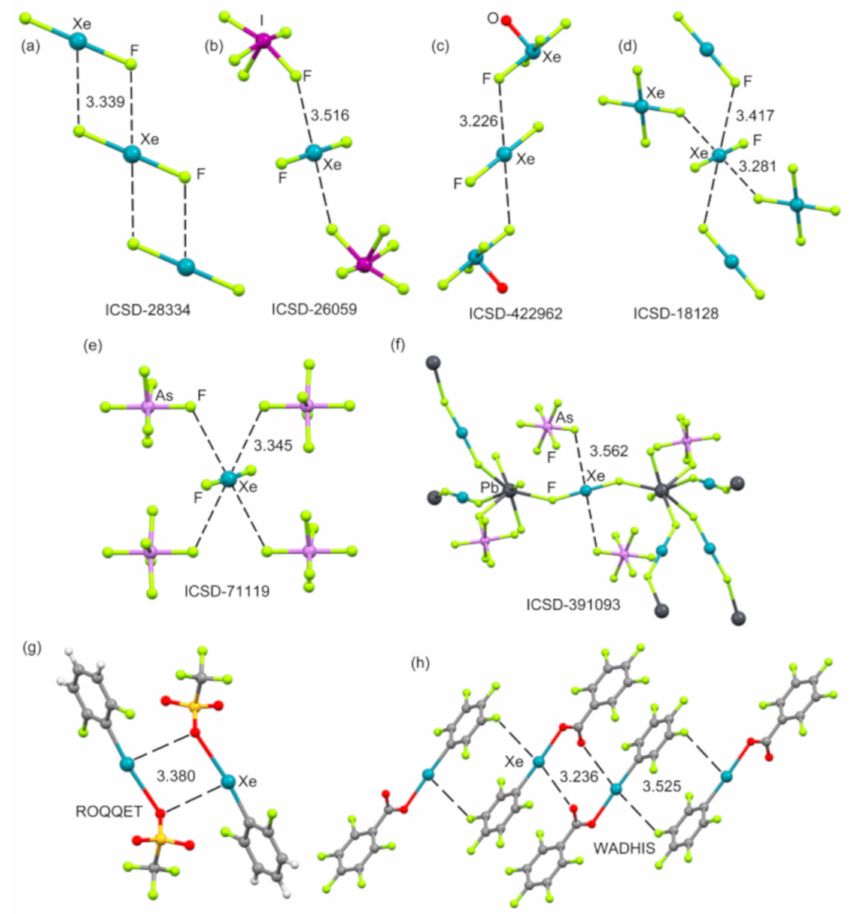
Figure 16. Partial views of the X-ray structures corresponding to ICSD and CSD reference codes ICSD-28334 ( a ), ICSD-26059 ( b ), ICSD-422962 ( c ), ICSD-18128 ( d ), ICSD-71119 ( e ), ICSD-391093 ( f ), ROQQET ( g ), and WADHIS ( h ), corresponding to xenon difluoride, xenon difluoride-iodine pentafluoride, xenon difluoride-xenon oxytetrafluoride, xenon difluoride-xenon tetrafluoride, Ag(XeF 2 ) 2 (AsF 6 ), Pb(XeF 2 ) 3 (AsF 6 ) 2 , 2,6-difluorophenyl-xenon trifluoromethanesulfonate, and pentafluorobenzoato-pentafluorophenyl-xenon, respectively. Distances in